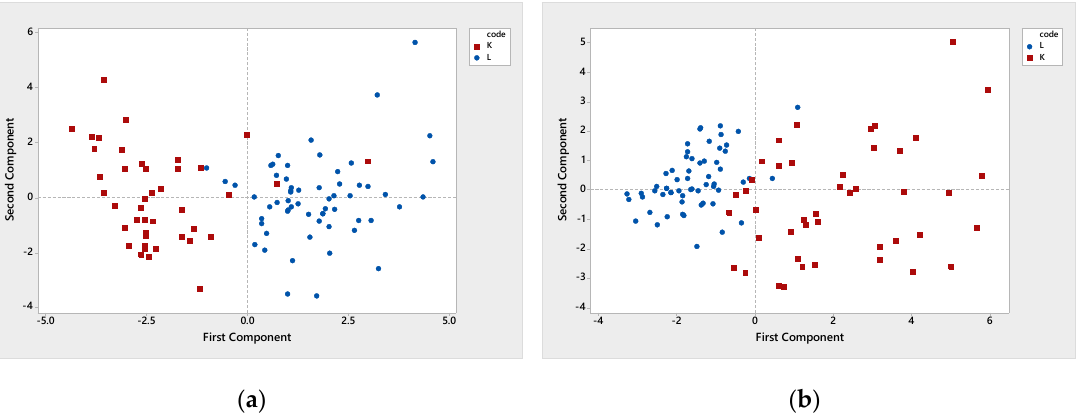
Figure 2. Score plot of principal component analysis (PCA) analysis based ( a ) on fatty acid ( b ) on the sterolic profiles of the examined monovarietal olive oils. K corresponds to Koroneiki olive oils (red spots) and L to Lianolia Kerkyras olive oils (blue spots).